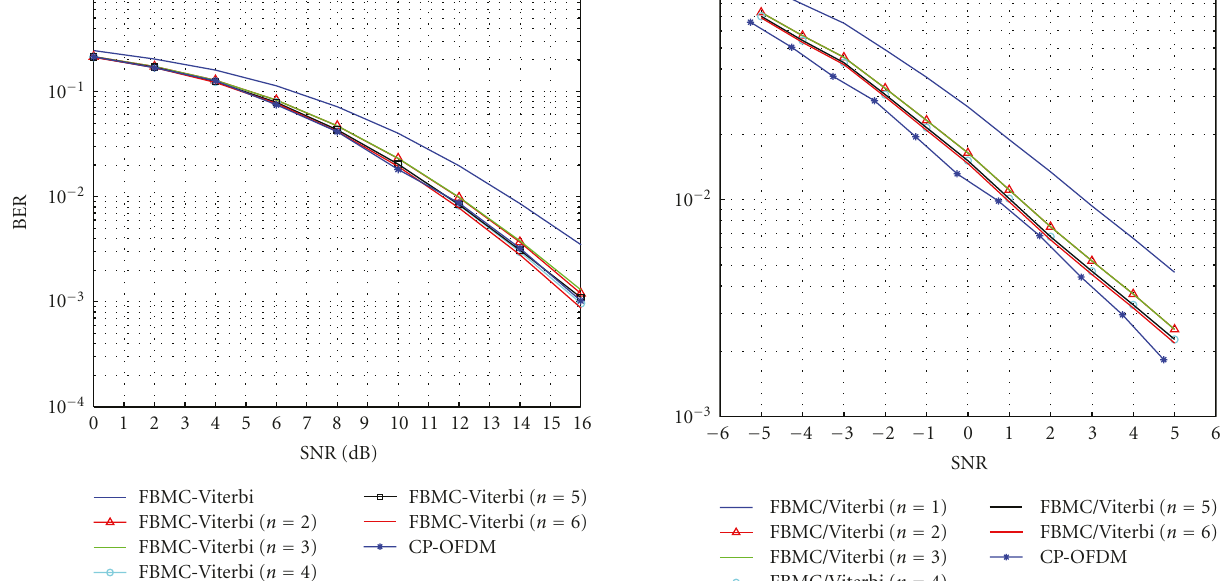
Figure 8: Performance of single delay STTC (iterative decoding) with 2 transmit antennas and one receive antenna over frequency selective